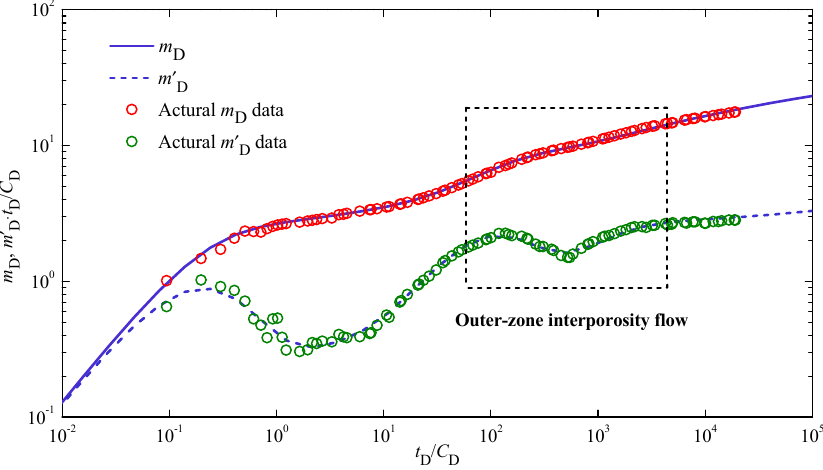
Figure 10. The log–log fitting curve for the X1 well. Table 3. The pressure transient analysis results of the X1 well.